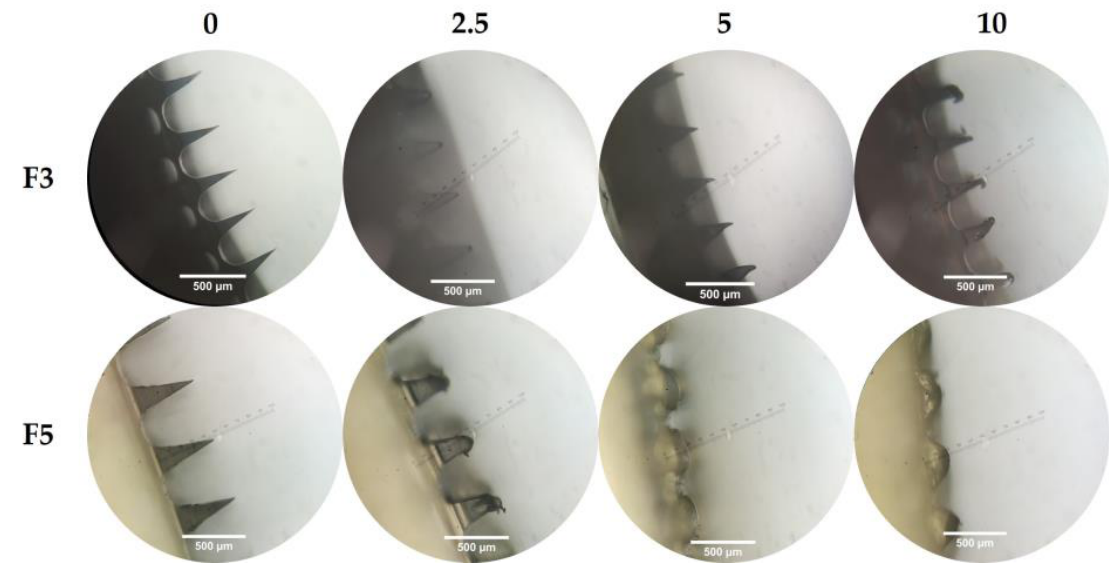
Figure 4. Dissolution of the needle of F3 and F5 in the skin with an interval of 0; 2.5; 5; 10 min (n = 3).